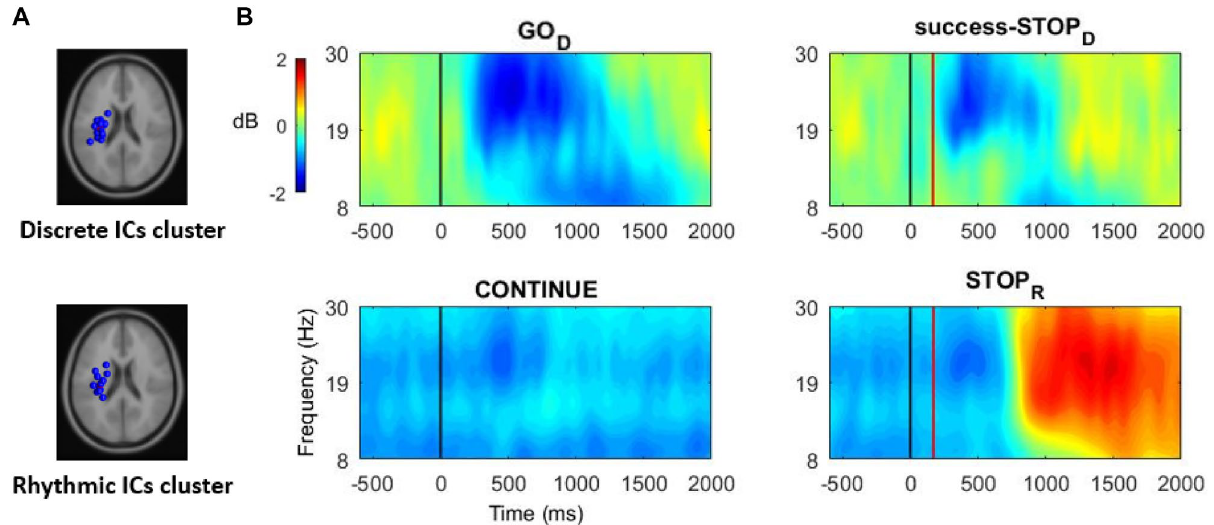
Figure 2. Component dimension time–frequency power analysis. Panel ( A ): Equivalent current dipoles of the clustered sensorimotor components in the discrete (15 participants, 20 ICs) and the rhythmic (15 participants, 19 ICs) experiments. Panel ( B ): Time–frequency power maps (ICs grand–average) computed in the discrete (GO D and success-STOP D ) and rhythmic (CONTINUE and STOP R ) conditions. Black line: Primary (GO or CONTINUE) stimulus onset. Red line: STOP signal onset (the represented onset is based on the average of the obtained SSD, over all the participants). The blue scale represents desynchronization and the red scale (re) synchronization of the brain